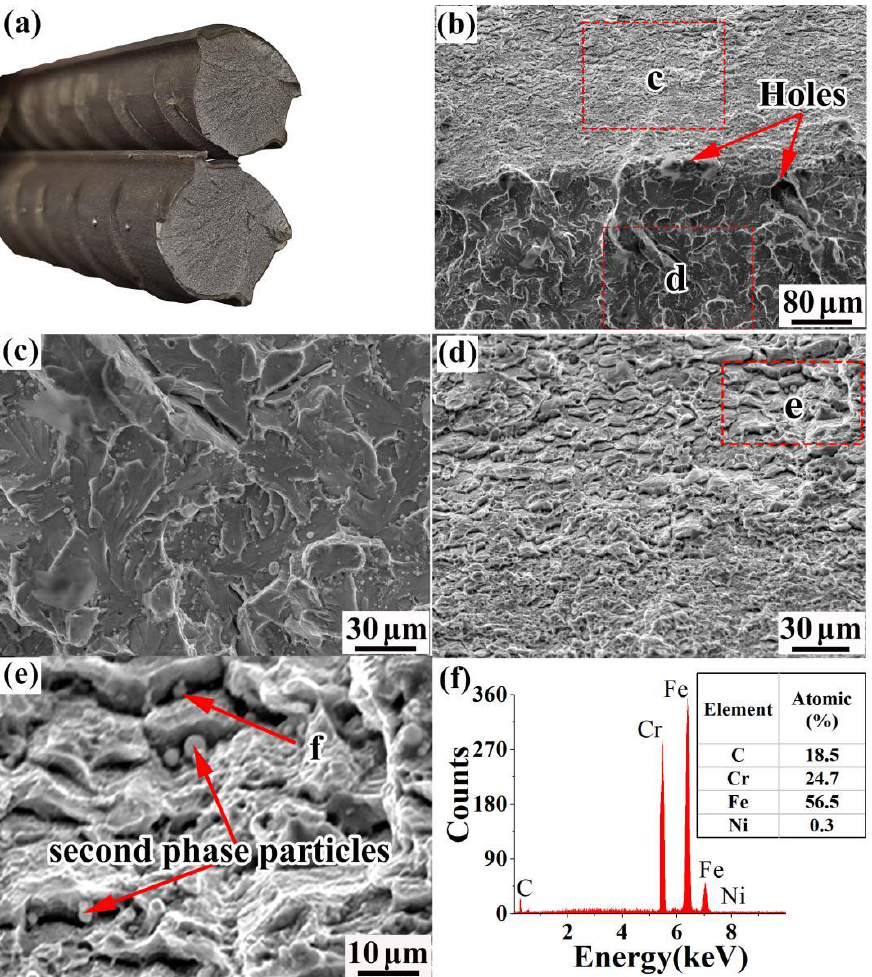
Figure 9. Tensile fracture morphology of the 55#/316L rebar: ( a ) macroscopic morphology, ( b ) microstructure of the composite interface, ( c ) tensile morphology of the stainless-steel sides, ( d ) tensile morphology of the carbon-steel sides, ( e ) particle distribution of the second-phase particles, and ( f ) chemical composition of the second-phase particles.